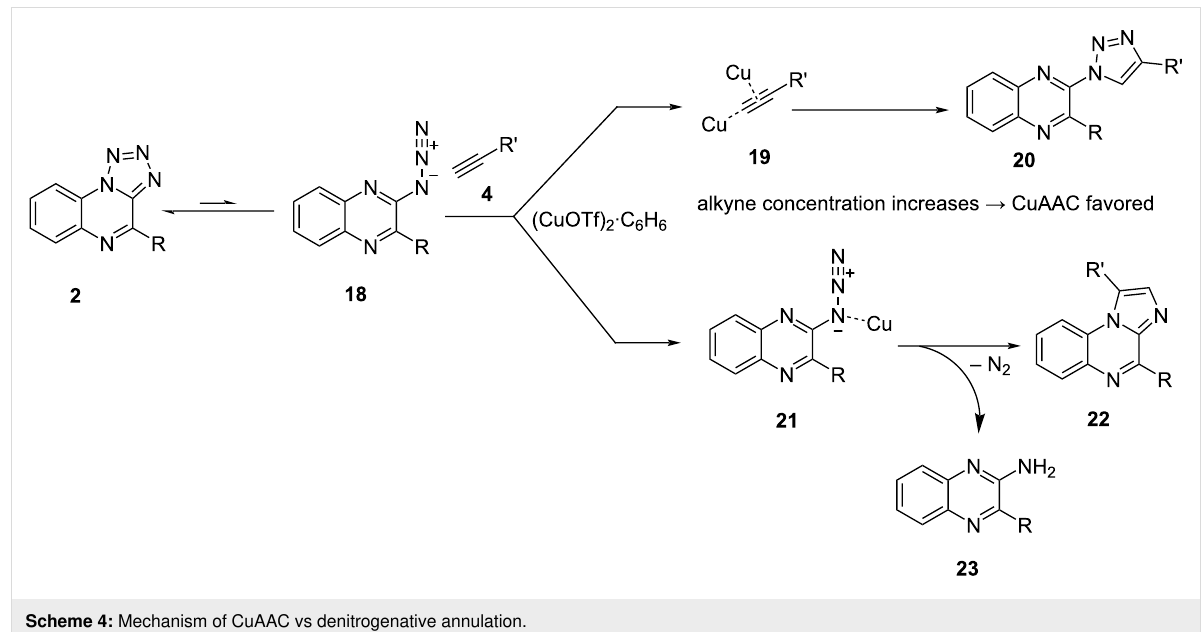
Scheme 4: Mechanism of CuAAC vs denitrogenative